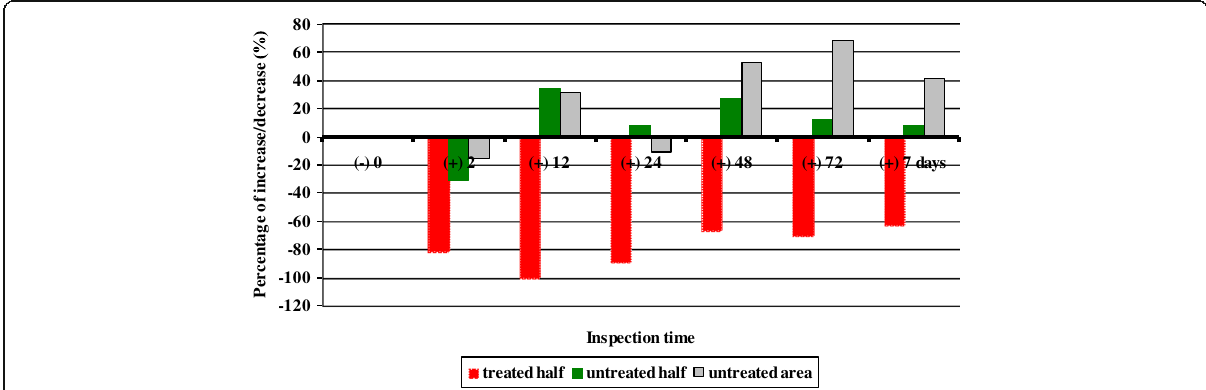
Fig. 2 Percentage of density fluctuations of Stethorus punctellium adults in untreated and sulfur-treated marrow